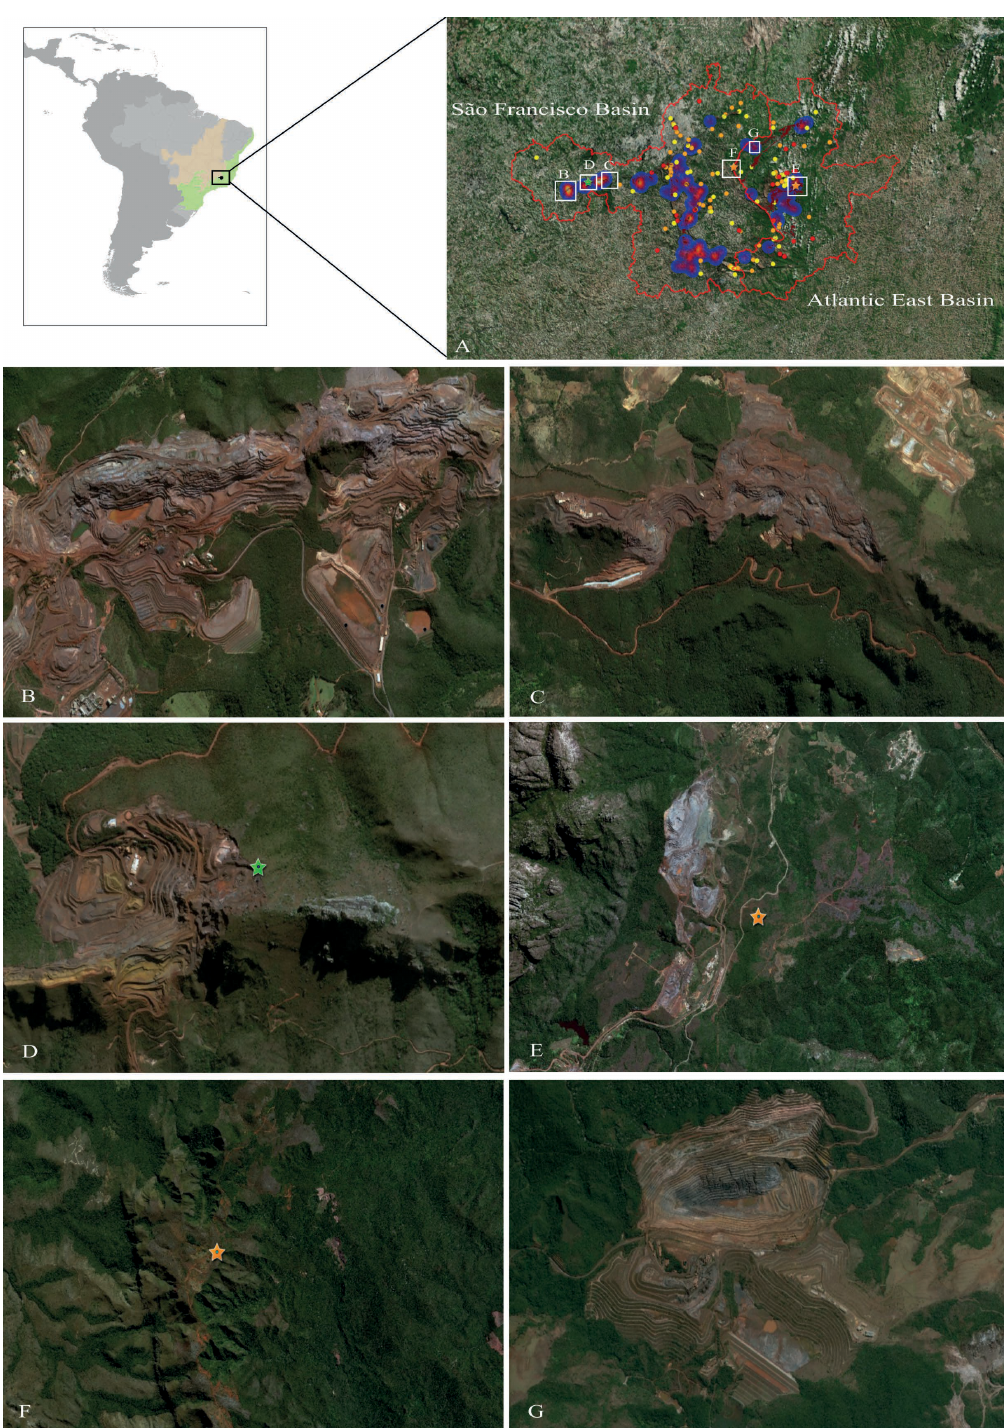
Figure 3 – Distribution of plants threatened by mining companies showing areas affected by iron ore exploitation in the Iron Quadrangle, Minas Gerais, Brazil. A . Distribution of vulnerable (yellow circles), endangered (orange), and critically endangered (red) species of vascular plants and density of mining companies (low to high: purple – red – white) (database from Instituto Prístino: https://www.institutopristino. org.br/atlas/geossistemas-ferruginosos-do-brasil/quadrilatero-ferrifero/baixe-os-arquivos-shp-e-kml/, accessed 28 Aug. 2019); red lines show river basin borders; phytogeographic domains in the map, light brown = Cerrado and green = Atlantic Forest. B – G . Details of areas affected by mining, with the type locality of Ditassa ferricola (green star in D); and Ditassa cangae (orange stars) in Chapada de Canga, Catas Altas (E) and Serra de Gandarela, Santa Bárbara (F) just south of Gongo Soco mine, Barão de Cocais (G). Satellite images and distribution maps were built and exported using ArcGIS online (https://www.arcgis.com). © Esri and its licensors, all rights reserved. This image is